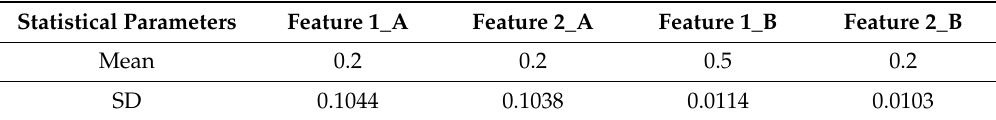
Table A2. The statistical parameters (mean and standard deviation (SD)) of the samples of A and B datasets. Statistical